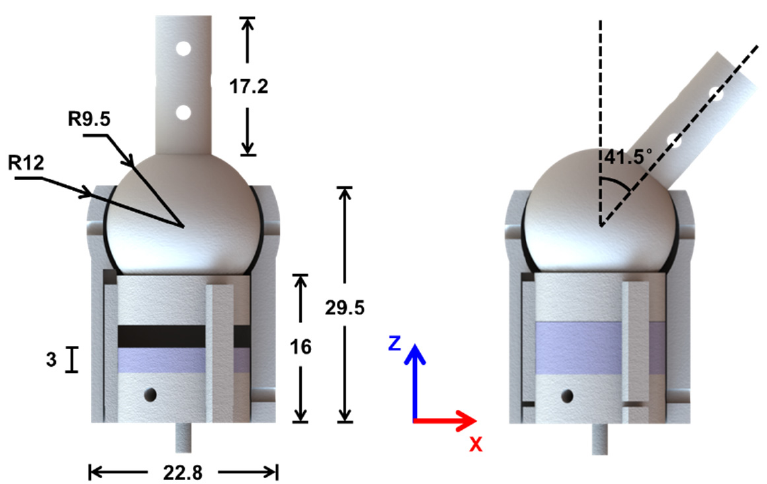
Figure 4. The dimensions in millimeters and rotational range of the VSBJ.